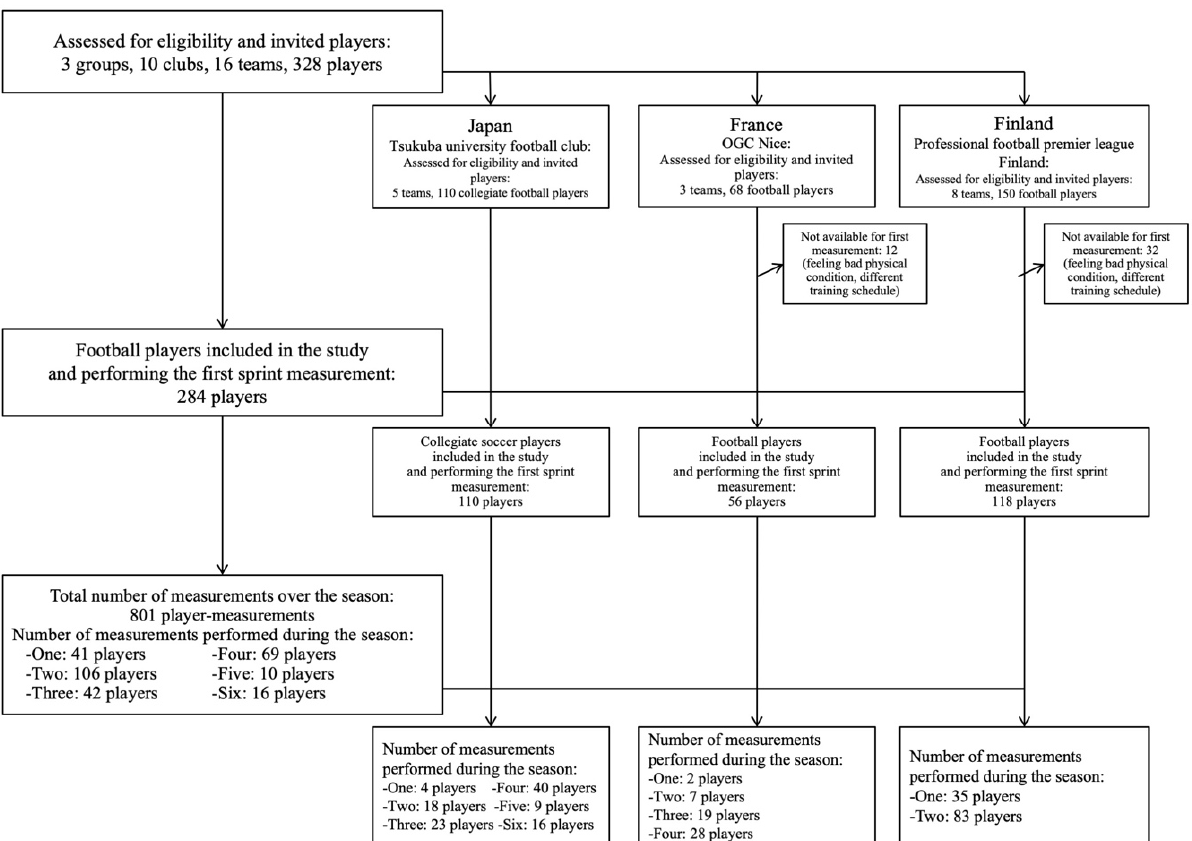
Figure 1. Flow chart showing the recruitment, number of included players and number of sprint acceleration. Table 1. Baseline data including anthropometrical, history of hamstring injury, and sprint acceleration mechanical output data at the start of the season, in addition to new hamstring injuries (i.e., primary outcome), for the total population and according to the three groups (i.e., Finland, Japan and France) or to the history of hamstring injury. Per Groups Per History of Hamstring Injury No Previous History of Previous Total Japan France Finland Hamstring Injury Hamstring Injury Number (n (%))